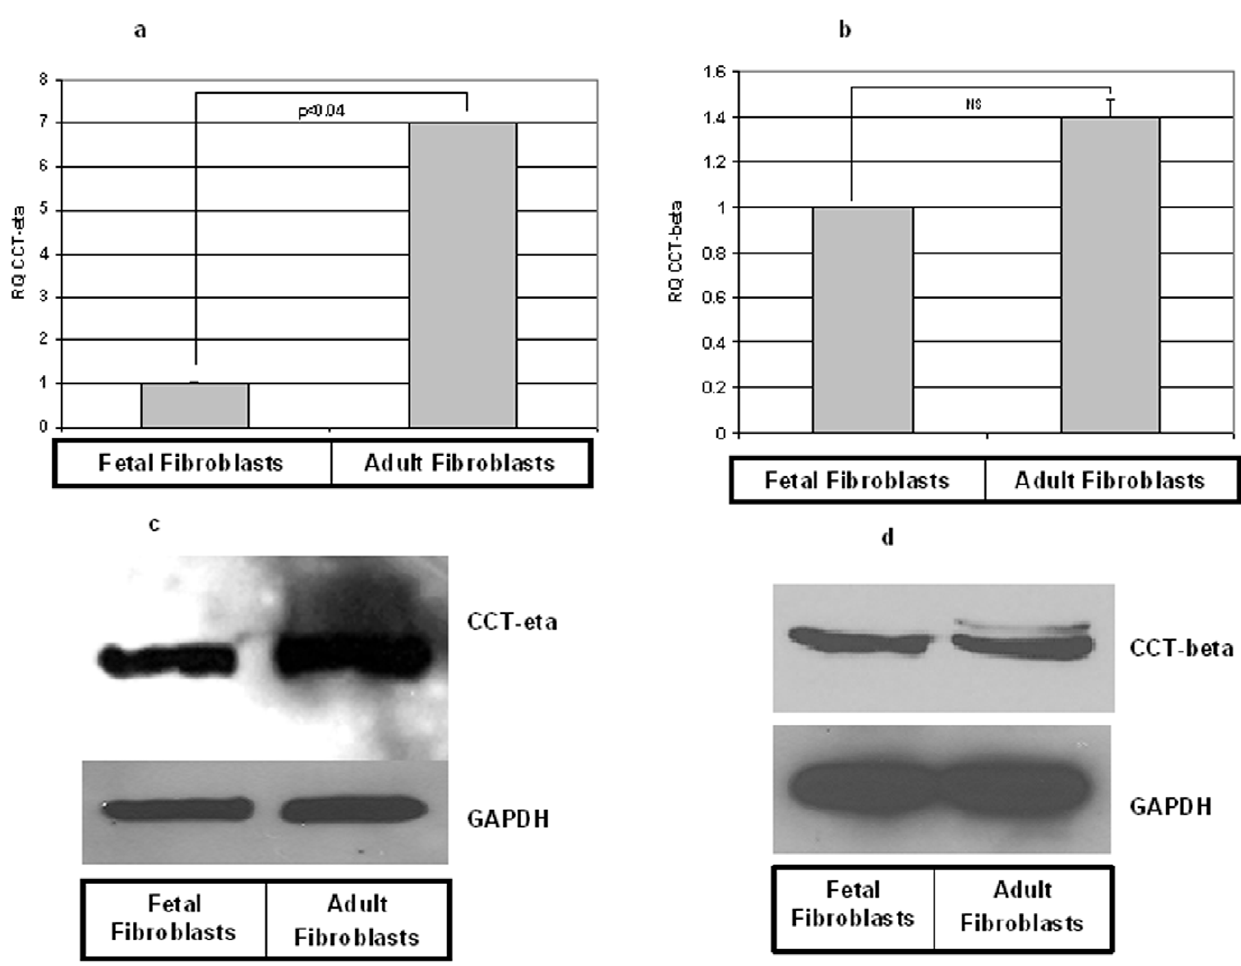
Figure 1. CCT-eta but not CCT-beta protein and mRNA are differentially expressed in fetal versus adult fibroblasts. RNA and protein extracted from fetal and adult fibroblasts were subjected to qRT PCR (a & b) and Western blot (c & d) analyses respectively. CCT-eta mRNA was significantly more abundant in adult fibroblasts when compared to fetal fibroblasts (a); there was no significant difference in CCT-beta message levels between fetal and adult fibroblasts (b). Values are means 6 SEM of three independent studies performed in duplicate. Statistical analyses were performed using Student’s t test. NS=non-significant. Equal amounts of protein loaded from fetal and adult fibroblasts showed that adult fibroblasts express significantly greater CCT-eta protein(c). In contrast CCT-beta protein levels were not different between fetal and adult fibroblasts (d). Blots shown here are representative of at least three different experiments.